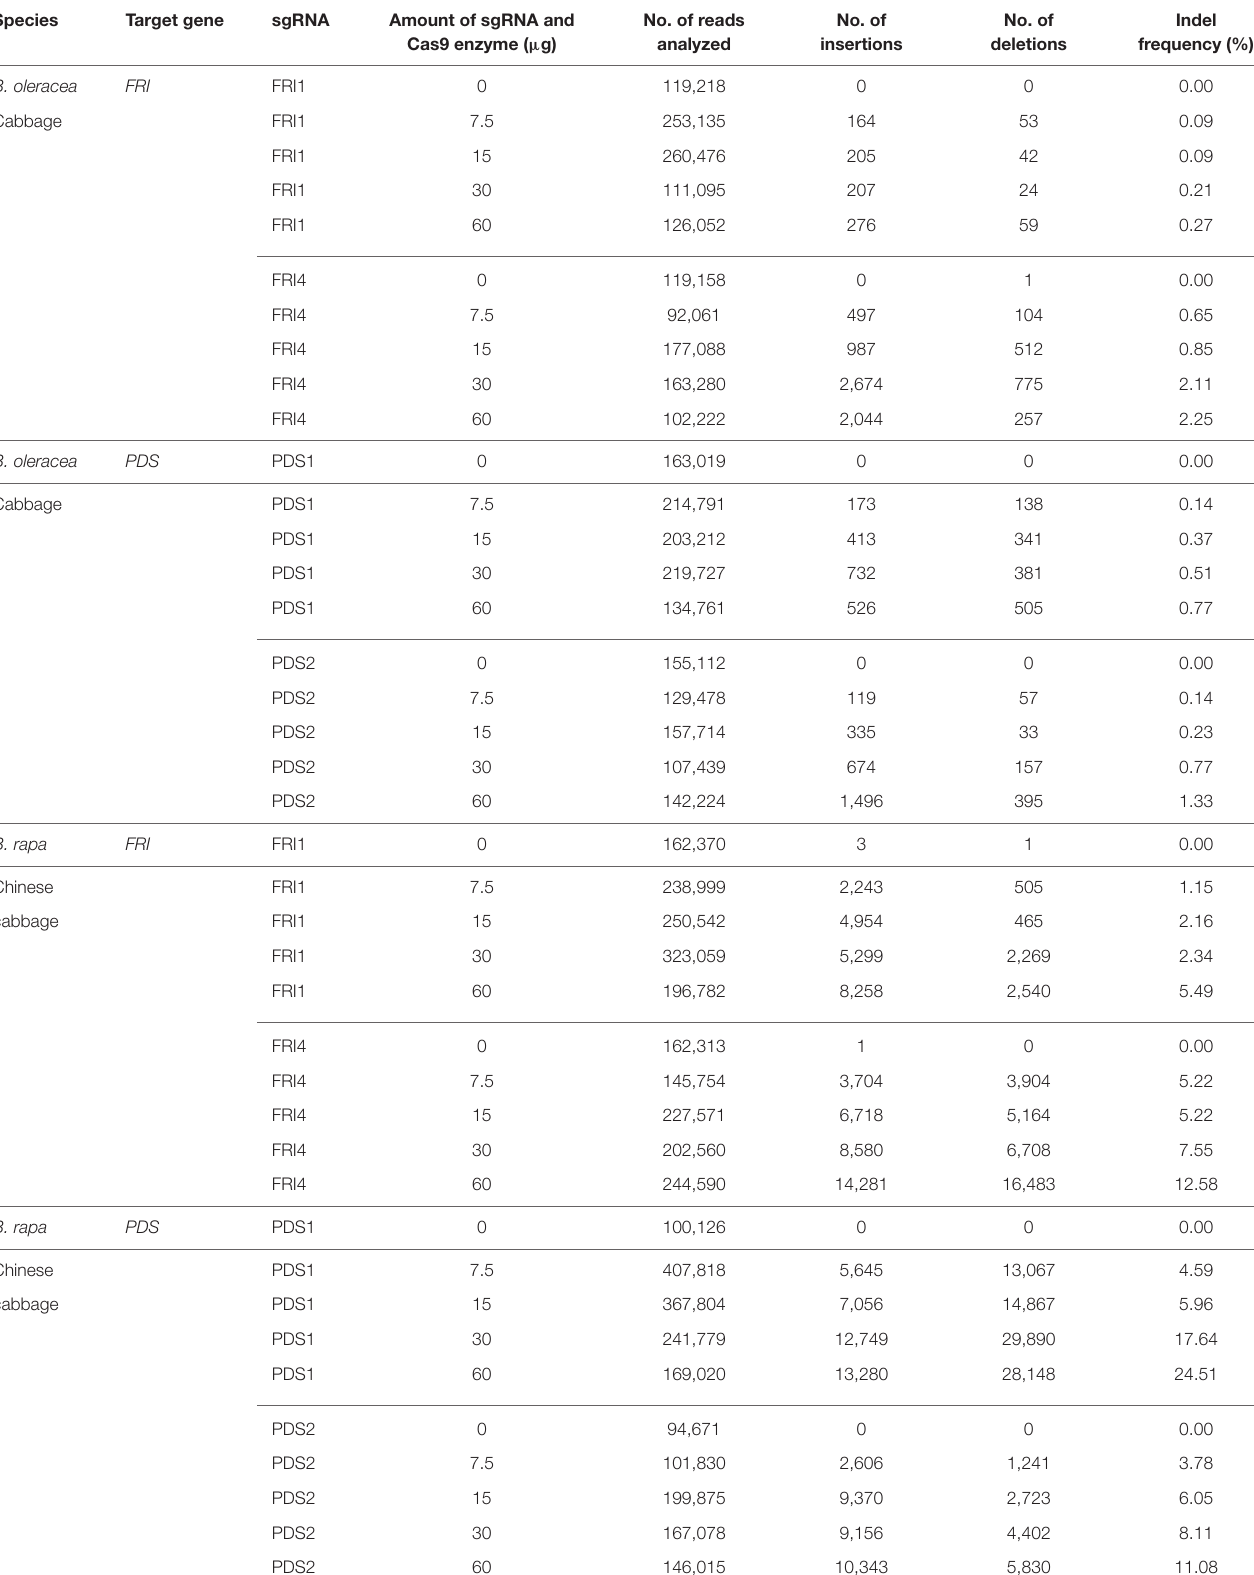
TABLE 3 | Mutation rates based on deep sequencing of target regions in FRI and PDS genes and analysis with Cas-Analyzer. Species Target